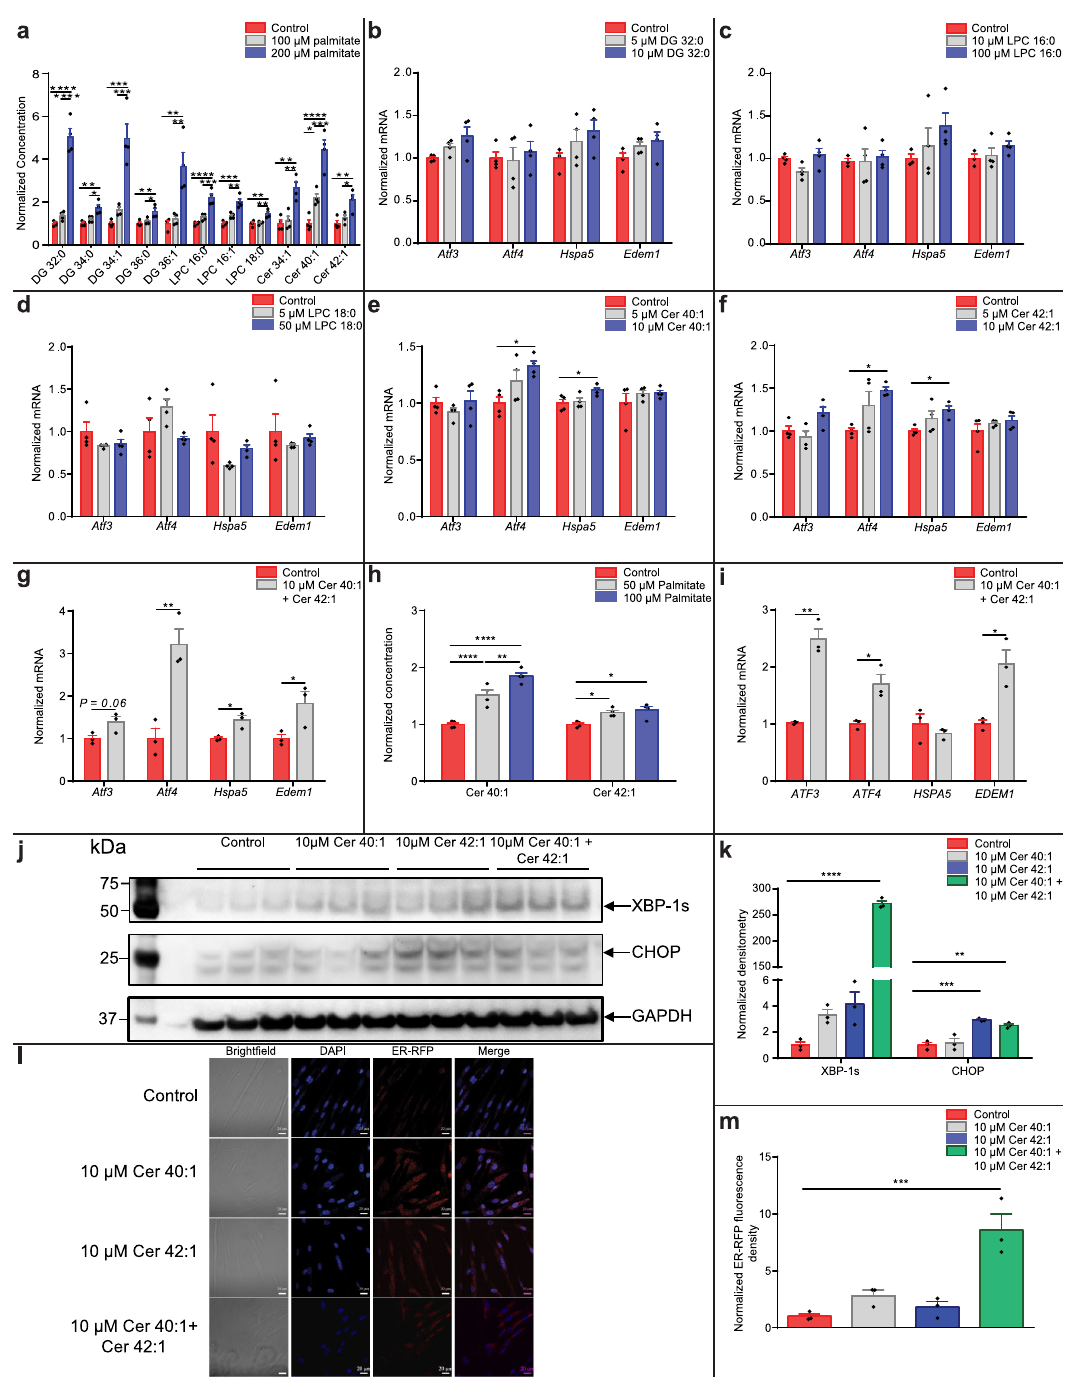
dose response in the physiological range found in plasma 22 – 24 , increased expression of Atf4 and Hspa5 . Combined treatment of myotubes with both ceramides 40:1 and 42:1 increased expression of Atf4 , Hspa5 and Edem1 , (increased expression of Atf3 trended to signi fi cance, p = 0.06) (Fig. 2g). However, treatment of myo- cytes with ceramide 34:1 had a limited effect on UPR gene expression, suggesting speci fi city within lipid class (Supplemen- tary Fig. 3b). Ceramides 40:1 and 42:1 (and ceramide 34:1) were also increased in concentration in media collected from HSkMCs treated with palmitate (Fig. 2h; Supplementary Fig. 3c). Treat- ment of HSkMCs with ceramides 40:1 and 42:1, was consistent with effects on murine myotubes with increased expression